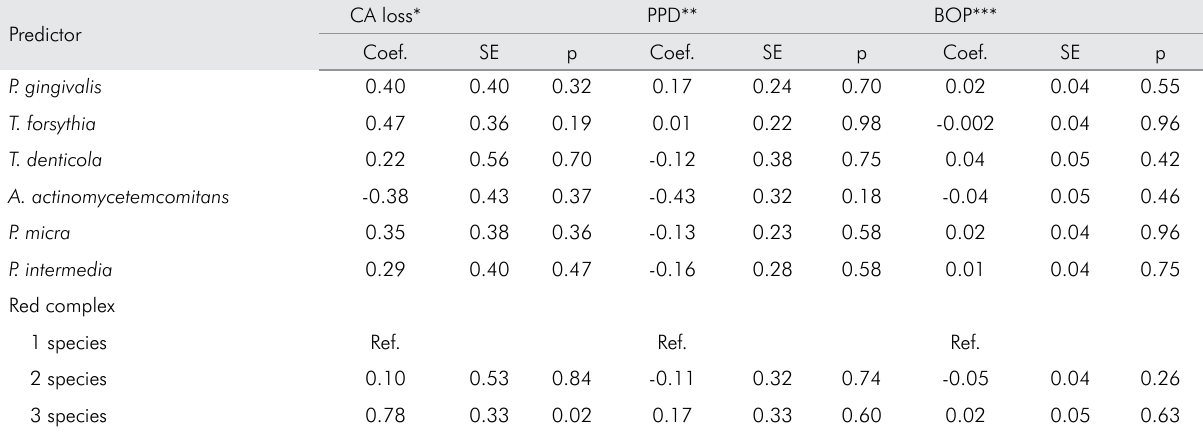
Table 5. Multivariable GEE models # of the presence of various bacterial species at baseline as predictors of CA loss, PPD and BOP changes over 12